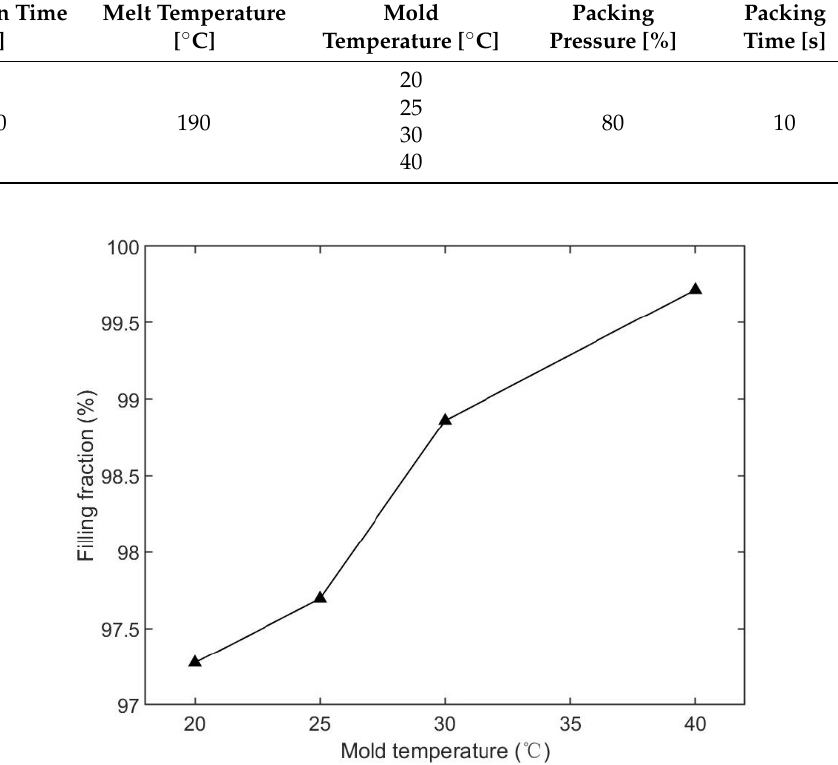
Figure 7. Relationship between the mold temperature and filling fraction, based on Table 5.